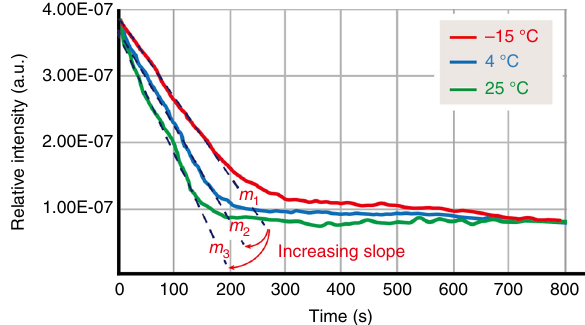
Fig. 3 Sublimation rate analysis. Real-time analysis of the sublimated water vapor vs. the elapsed time at varied operating temperatures, 25, 4, and − 15 °C. The decreasing water vapor intensity correlated to the mass transport rate of the water vapor (sublimation rate) due to the decreasing ice particle volume from sublimation. The sublimation rate was also a function of the operating temperature, and a higher temperature resulted in a higher sublimation rate, which was indicated by a deeper slope in the curve. Based on the slope m 1 ( − 15 °C), m 2 (4 °C) increase by 35.3 ± 2.0 %, and m 3 (25 °C) increased by 79.1 ± 6.2%. The slopes of the curves gradually fell to a value close to zero, which was indicative of the complete depletion of the water vapor via sublimation. The mean value ± S.D. was calculated from three independent